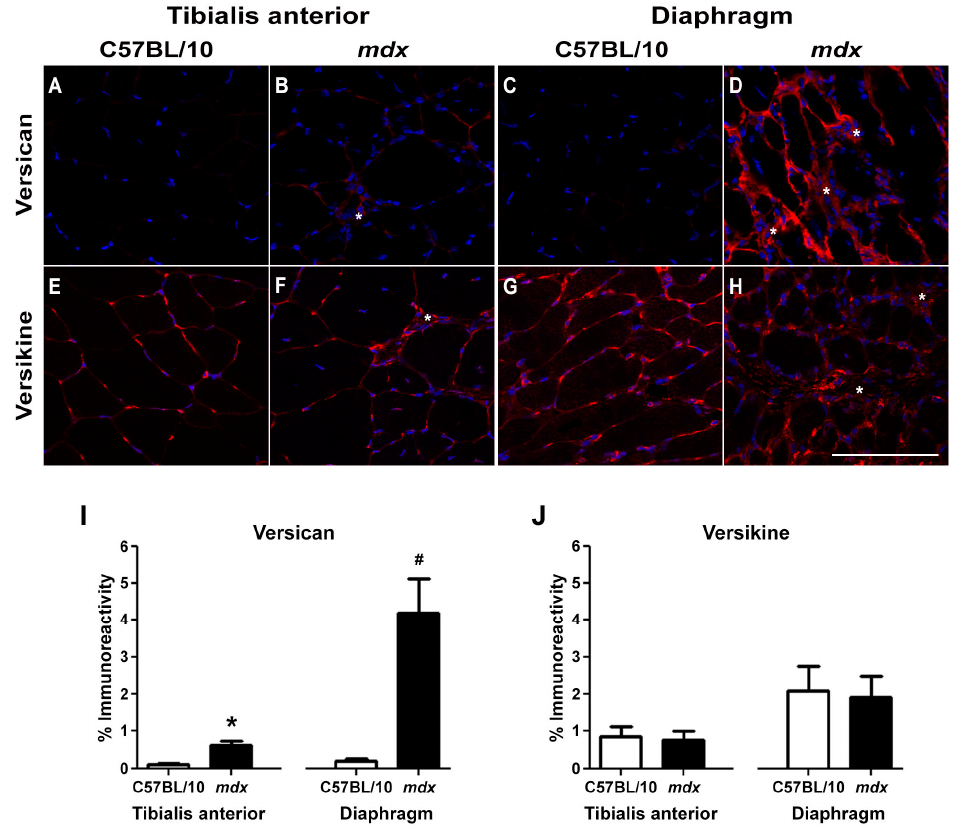
Figure 2. Versican and versikine expression in TA and diaphragm muscles from wild type and mdx mice. Representative images of ( A – D ) versican and ( E – H ) versikine immunoreactivity from TA and diaphragm muscles from wild type and mdx mice. ( I ) Quantification of versican immunoreactivity revealed an upregulation in TA (* p = 0.001) and diaphragm muscles ( # p = 0.0001) from mdx mice when compared to wild type mice. ( J ) Versikine immunoreactivity was similar in mdx and wild type TA or diaphragm muscles. White asterisks denote areas of mononuclear infiltration. Immunoreactivity analysis was determined from n = 5 wild type mice and n = 5 mdx mice. Scale bar = 100 µm. Error bars = S.E.